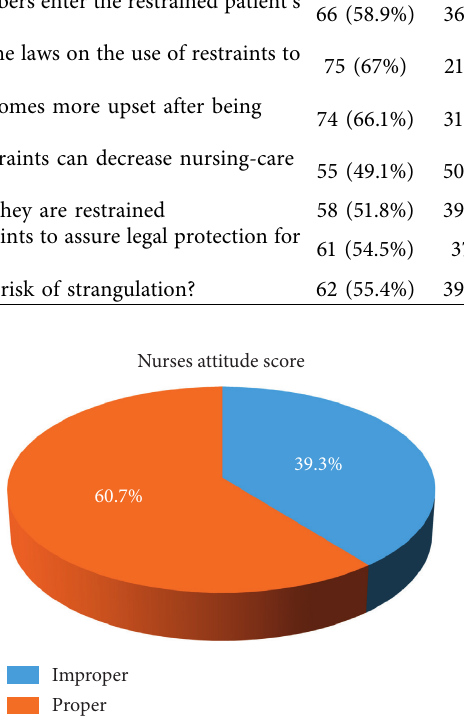
Figure 3: Category of nurses’ attitude regarding physical restrain ( n � 112). Table 4: Selected items measuring participant nurses’ practice regarding physical restraint use at federally administered hospitals in Addis Ababa, 2019 ( n � 112) ( n �